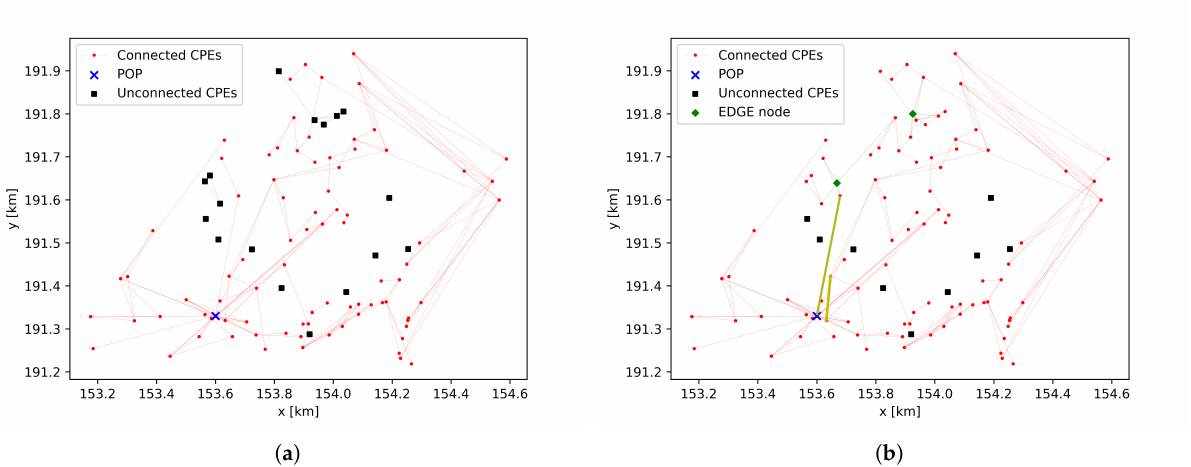
Figure 7. Graph representation of a simulation in village environment with 100 CPE devices. ( a ) Graph representation. ( b ) Two EDGE devices